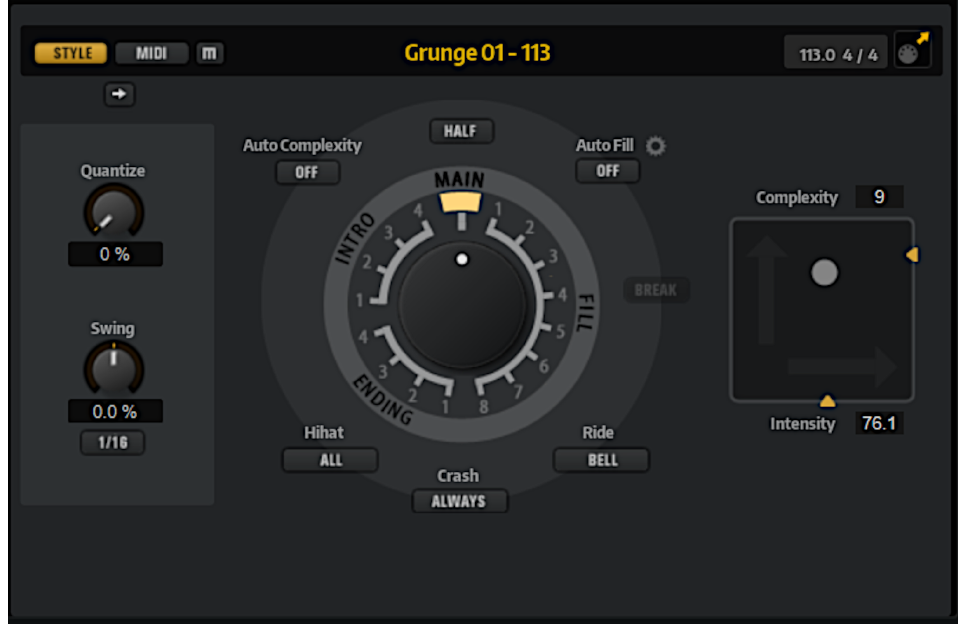
Figure 1. The pattern management area in Steinberg Groove Agent 5. On the right, the two- dimensional control surface (that also works in real time) is dedicated to the intensity and complexity parameters. Courtesy of Steinberg Media Technologies